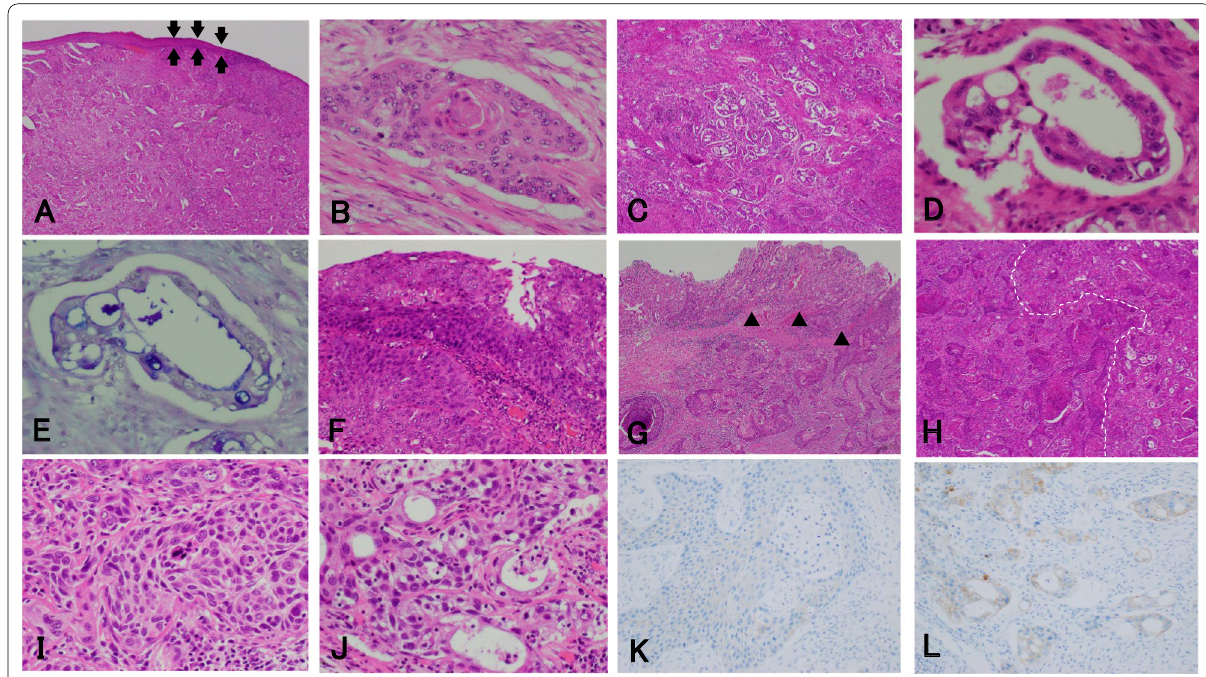
Fig. 5 Histopathologic findings. A Low-power magnification of SCC in hematoxylin and eosin staining (HE). SCC, covered with the normal squamous epithelium, is infiltrated diffusely in the tumor (arrows). B High-power magnification of SCC (HE). SCC is moderately differentiated. C Low-power magnification of adenocarcinoma (HE). Scattered adenocarcinoma nests are observed in the tumor. D High-power magnification of adenocarcinoma (HE). Adenocarcinoma is well-differentiated. E AB-PAS staining shows blue adenocarcinoma cells. F Superficial SCC in the squamous epithelium of the lower esophagus. G Distal part of SCC is covered with the normal columnar epithelium (arrowheads). H Several transition parts between SCC and adenocarcinoma components are observed in the primary tumor. The left panel shows SCC (left side on the dashed line) and the right panel shows the adenocarcinoma component (right side on the dashed line). I The SCC component is observed in the No. 11p nodes dissected. J The adenocarcinoma component is observed in the No. 11p nodes synchronously. K No reaction for HER2 is be 2 +